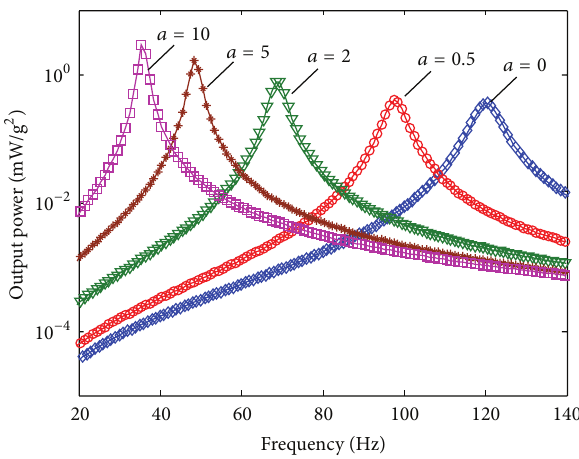
Figure 7: Output power for the PVEH with various mass ratios 𝑎 when 𝑅 𝐿 = 1 k Ω